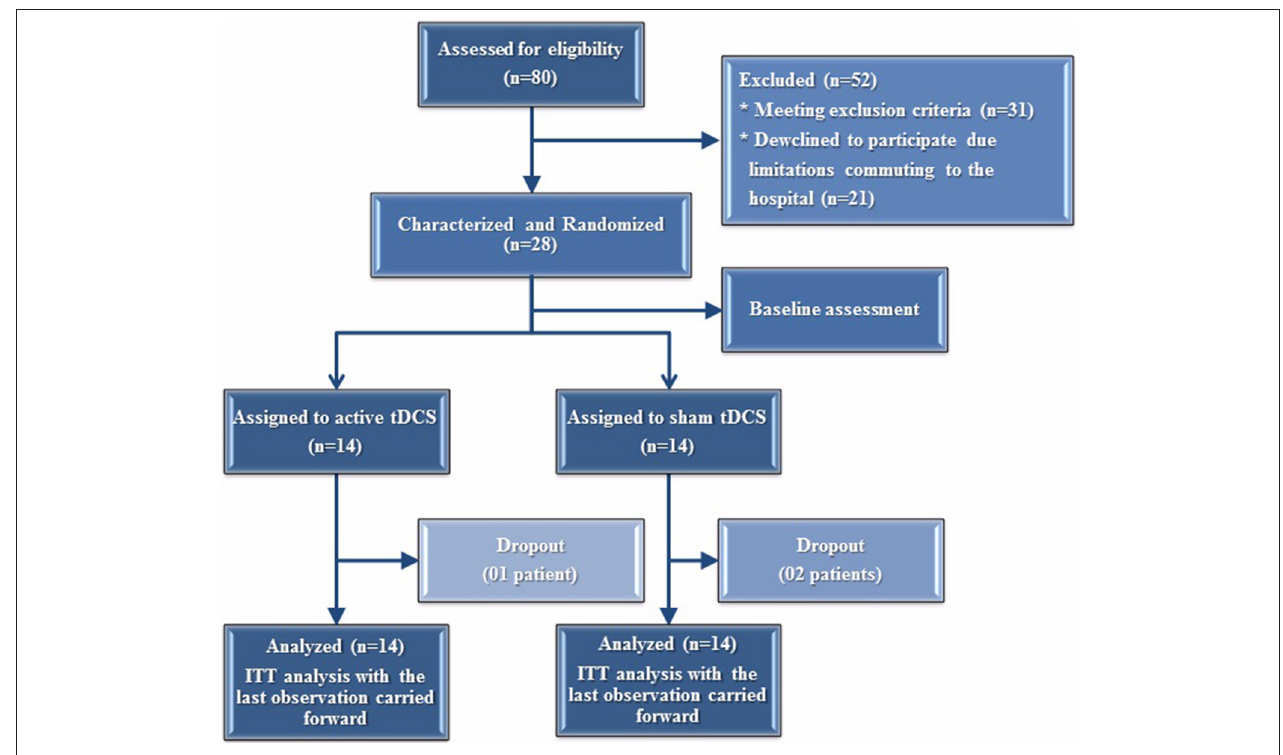
FIGURE 1 | Randomization and follow-up of the study subjects.